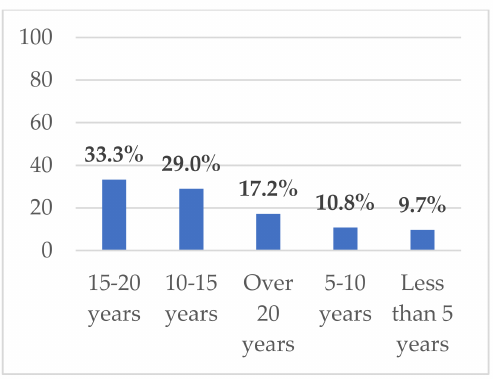
Figure 6. Respondents’ years of experience in the construction